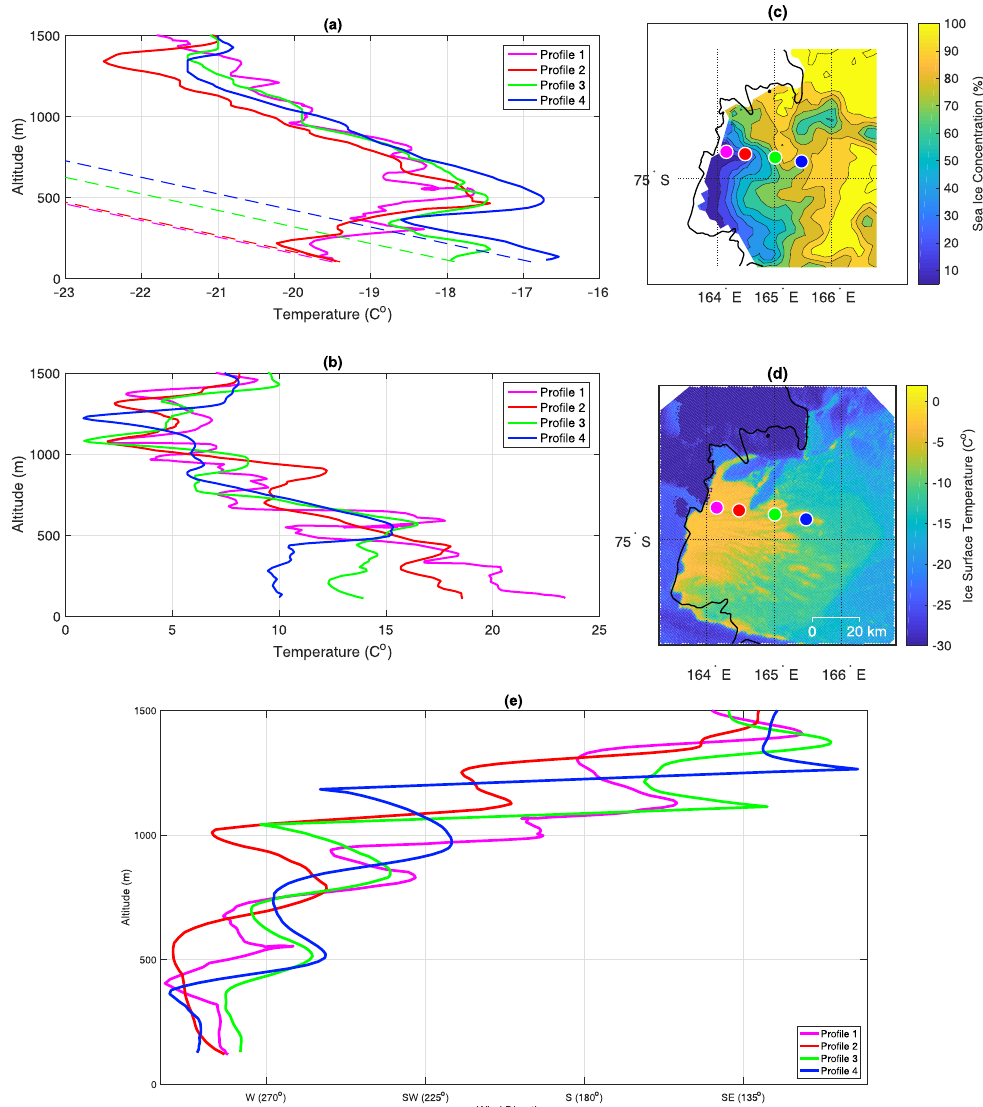
Figure 8. UAS Aerosonde measurements from 22nd of September 2012. Subfigures labelled as in Figure 6. Profiles started at: 07:56 UTC (1); 08:34 UTC (2); 09:21 UTC (3); 10:05 UTC